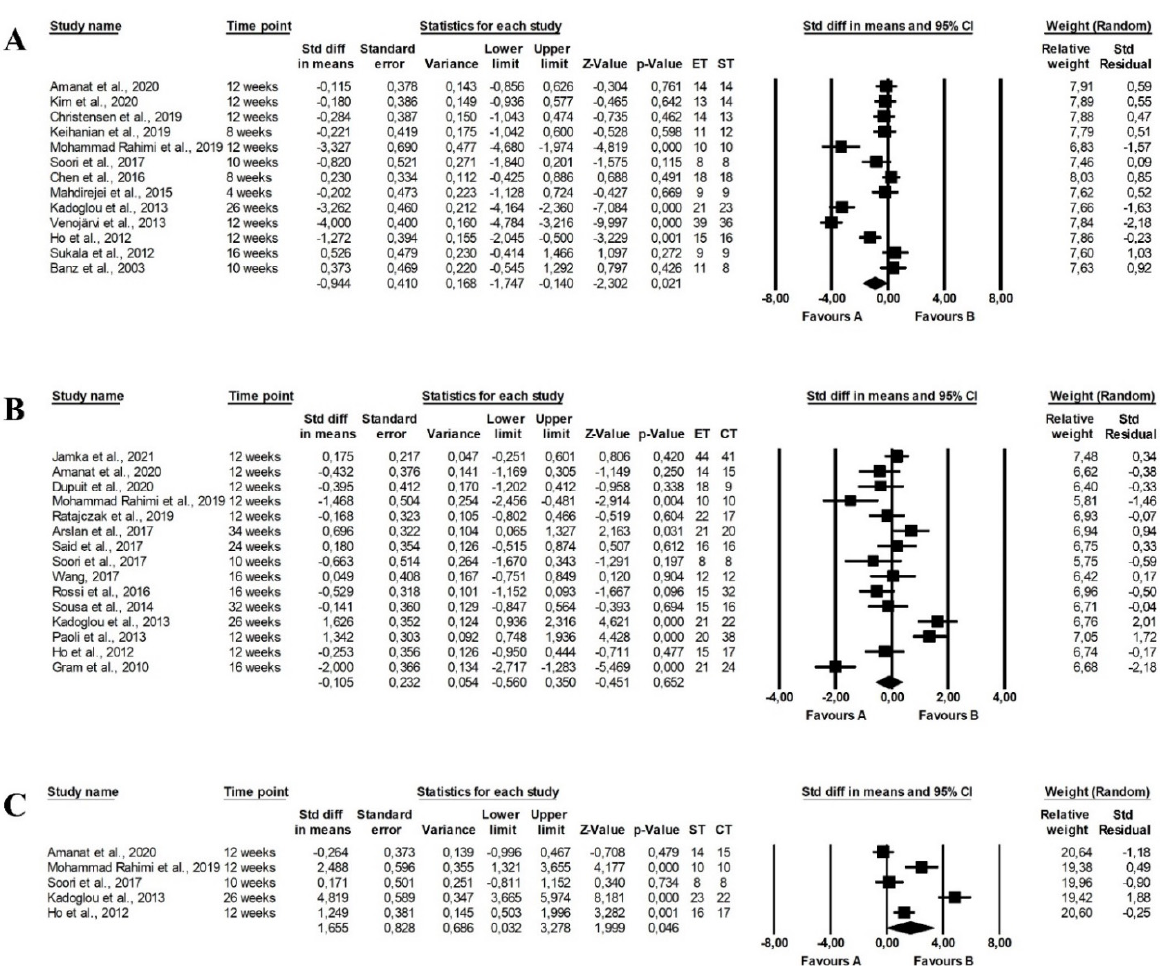
Figure 10. Forest plots of the effect of training programmes on low-density lipoprotein